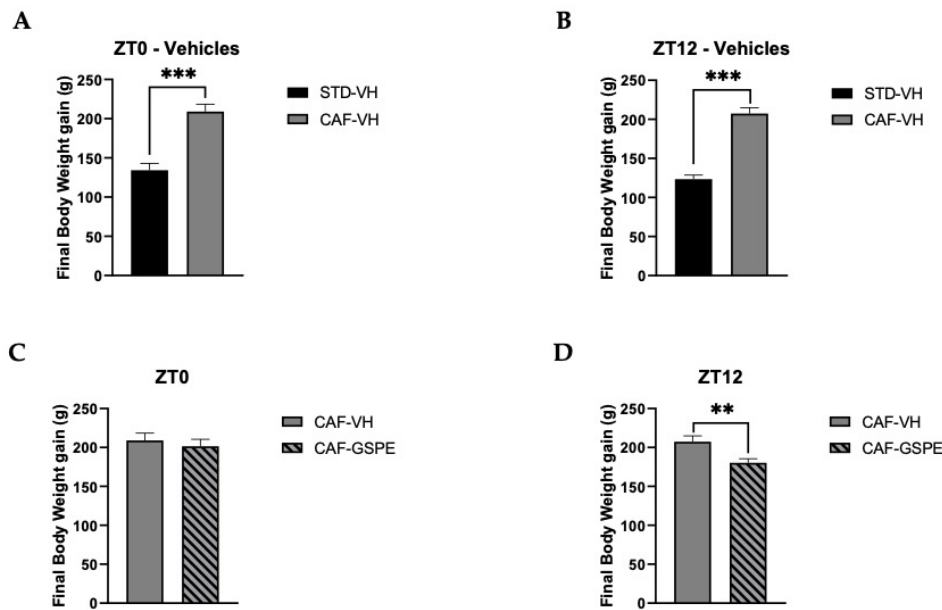
Figure 1. Body-weight gain (g). ( A ) Body-weight gain in grams of ZT0-vehicle rats (standard diet- vehicle (STD-VH) and cafeteria-diet-vehicle rats (CAF-VH) in the nine weeks of the experiment. ( B ) Body-weight gain in grams of ZT12-vehicle rats (STD-VH and CAF-VH) in the nine weeks of the experiment. ( C ) Body-weight gain in grams of ZT0-CAF-VH and cafeteria diet–grape-seed proanthocyanidin extract (CAF-GSPE) groups in the nine weeks of the experiment. ( D ) Body-weight gain in grams of ZT12 CAF-VH and CAF-GSPE groups in the nine weeks of the experiment. *** Indicates significant differences using repeatedly measured ANOVA followed by Student’s t test between VH groups (STD-VH vs. CAF-VH) ( p ≤ 0.001); ** indicates significant differences within CAF groups (CAF-VH vs. CAF-GSPE) ( p ≤ 0.01)